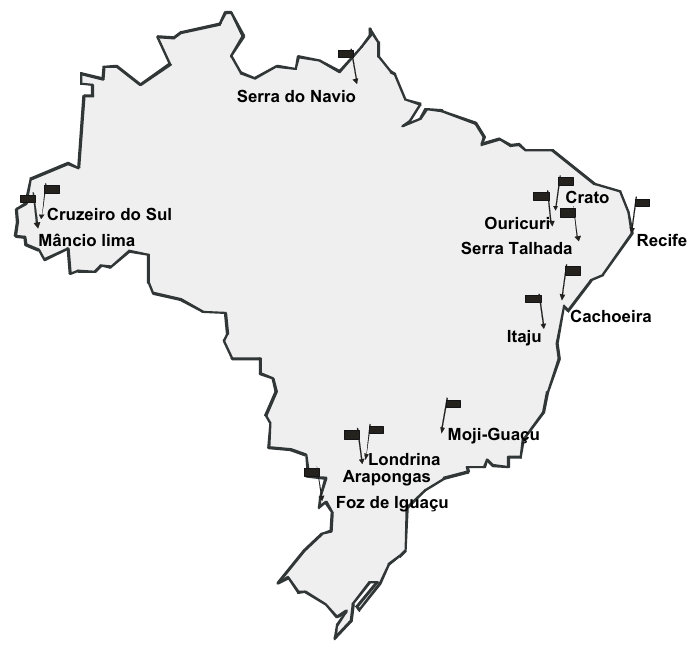
Fig. 1–BrazilianlocalitiesfromwhichsamplesofBlue-blackGrassquit Volatinia jacarina songs were obtained for sonographic